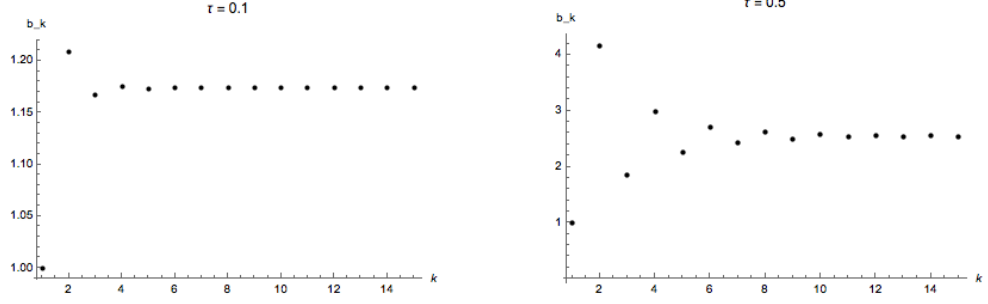
Figure 1 . Convergence of the sequence f b k g